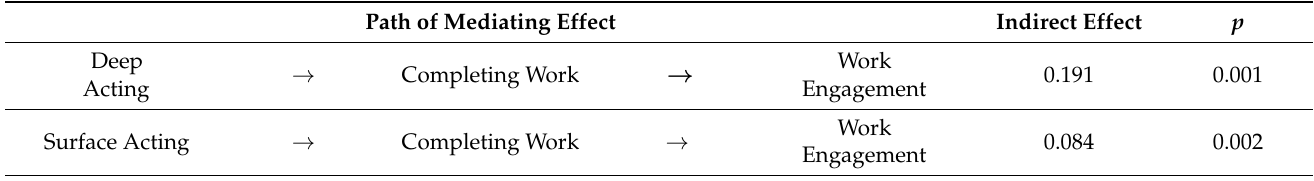
Table 6. Test of mediating